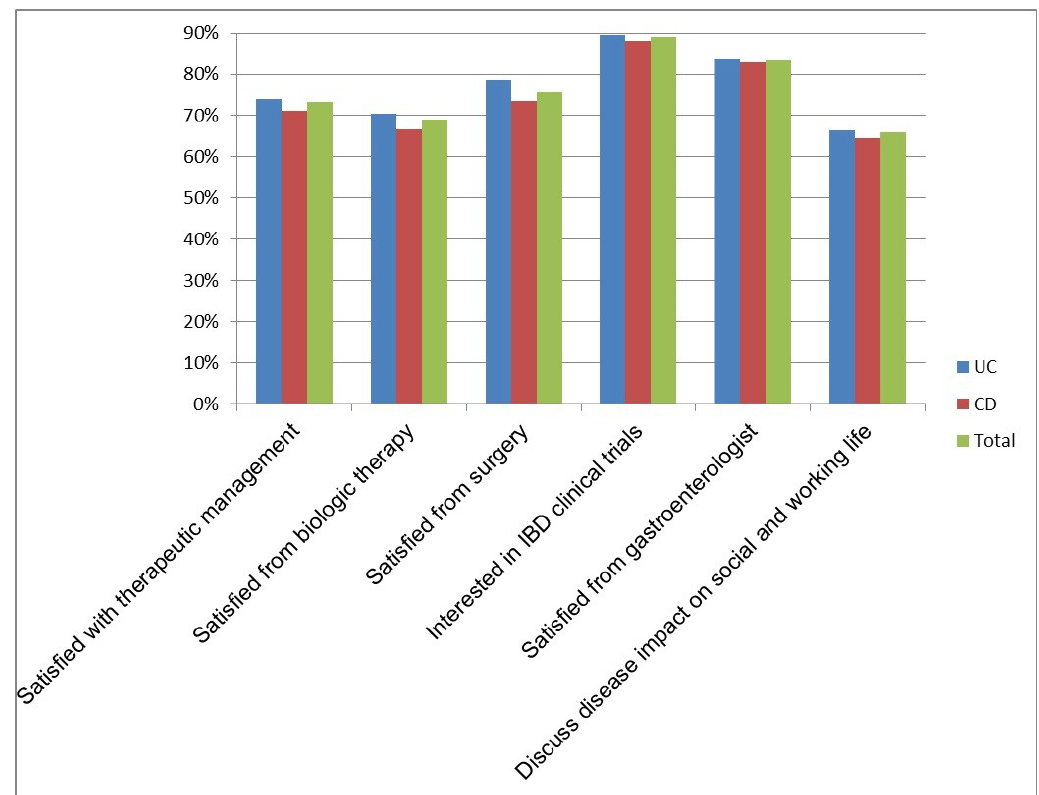
Figure 3. Reality of health-related quality of life and unmet needs (percentages of affirmative responses) among the 202 IBD patients in remission ( n = 143 UC and n = 59 CD), as assessed by specific items [20].